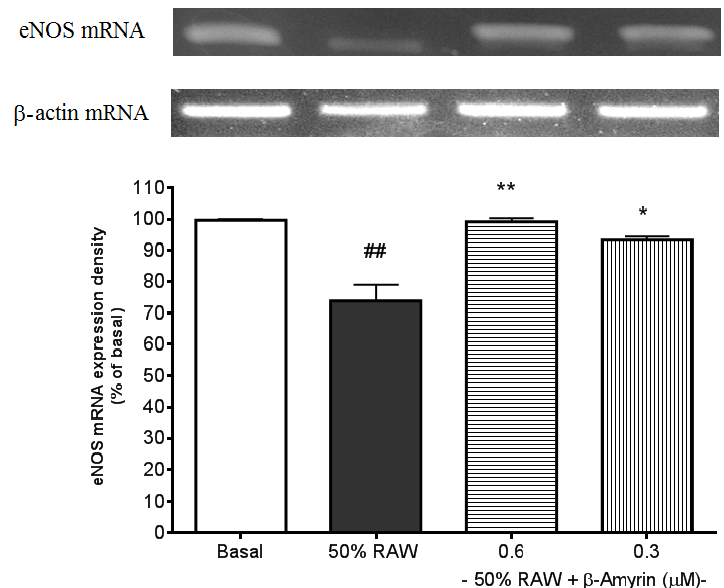
Figure 6. Effects of β -amyrin on proinflammatory cytokine-induced eNOS mRNA expression. SVEC4-10 endothelial cells ( n = 8) were treated with 50% RAW conditioned medium with and without β -amyrin (0.6 and 0.3 µM) for 24 h prior to total RNA extraction and PCR were performed. Statistics are shown for 50% RAW conditioned medium-treated cells. ## p < 0.01 compared to the basal; 0.6 µM of β -amyrin. ** p < 0.01 and 0.3 µM of β -amyrin. * p < 0.05 compared to 50% RAW conditioned medium-treated